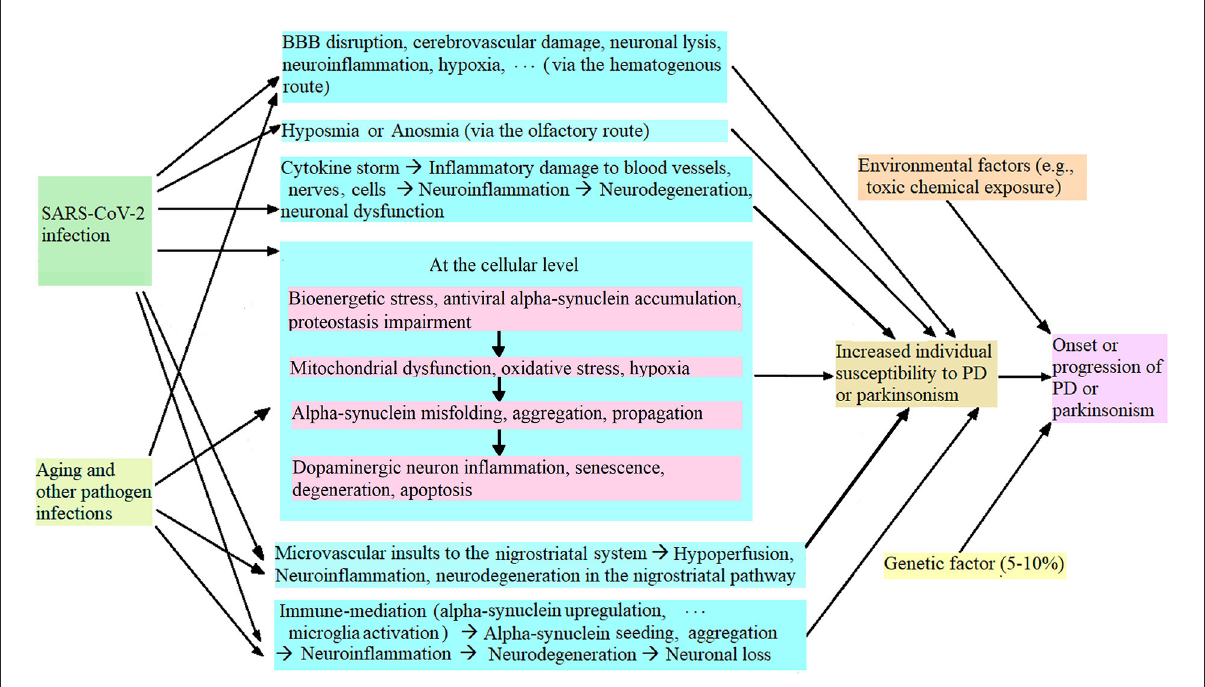
FIGURE1 Potential mechanism of SARS-CoV-2 infection leading to increased individual vulnerability to PD or